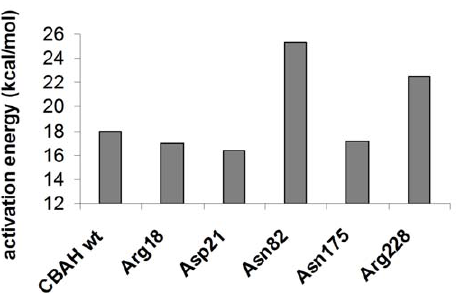
Figure 8. Activation barriers for TAU hydrolysis as obtained from steered-MD/PCVs simulations. Barriers are estimated from work profiles and are refereed to CBAH wild type (wt) and to zero-point charge